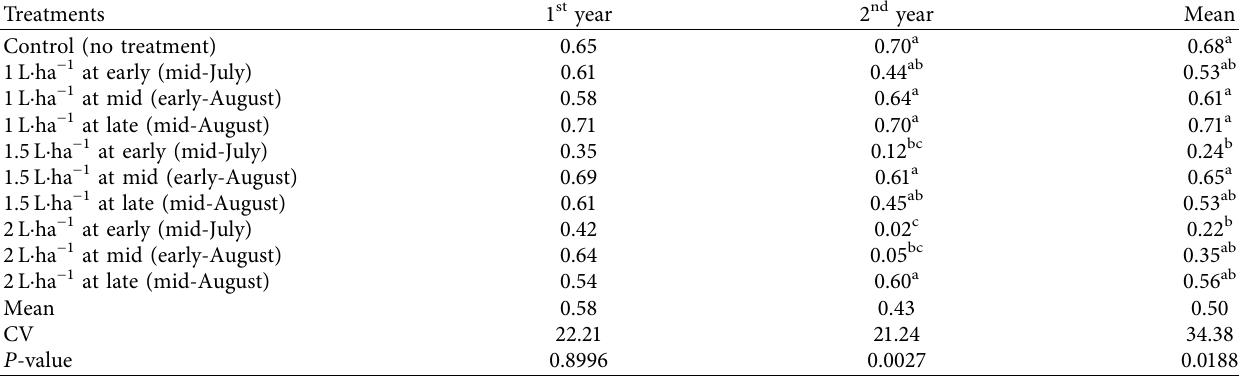
Table 10: Effect of the interaction of dose and time of 2, 4-D application on dry matter yield (t · ha − 1 ) of weeds. Treatments